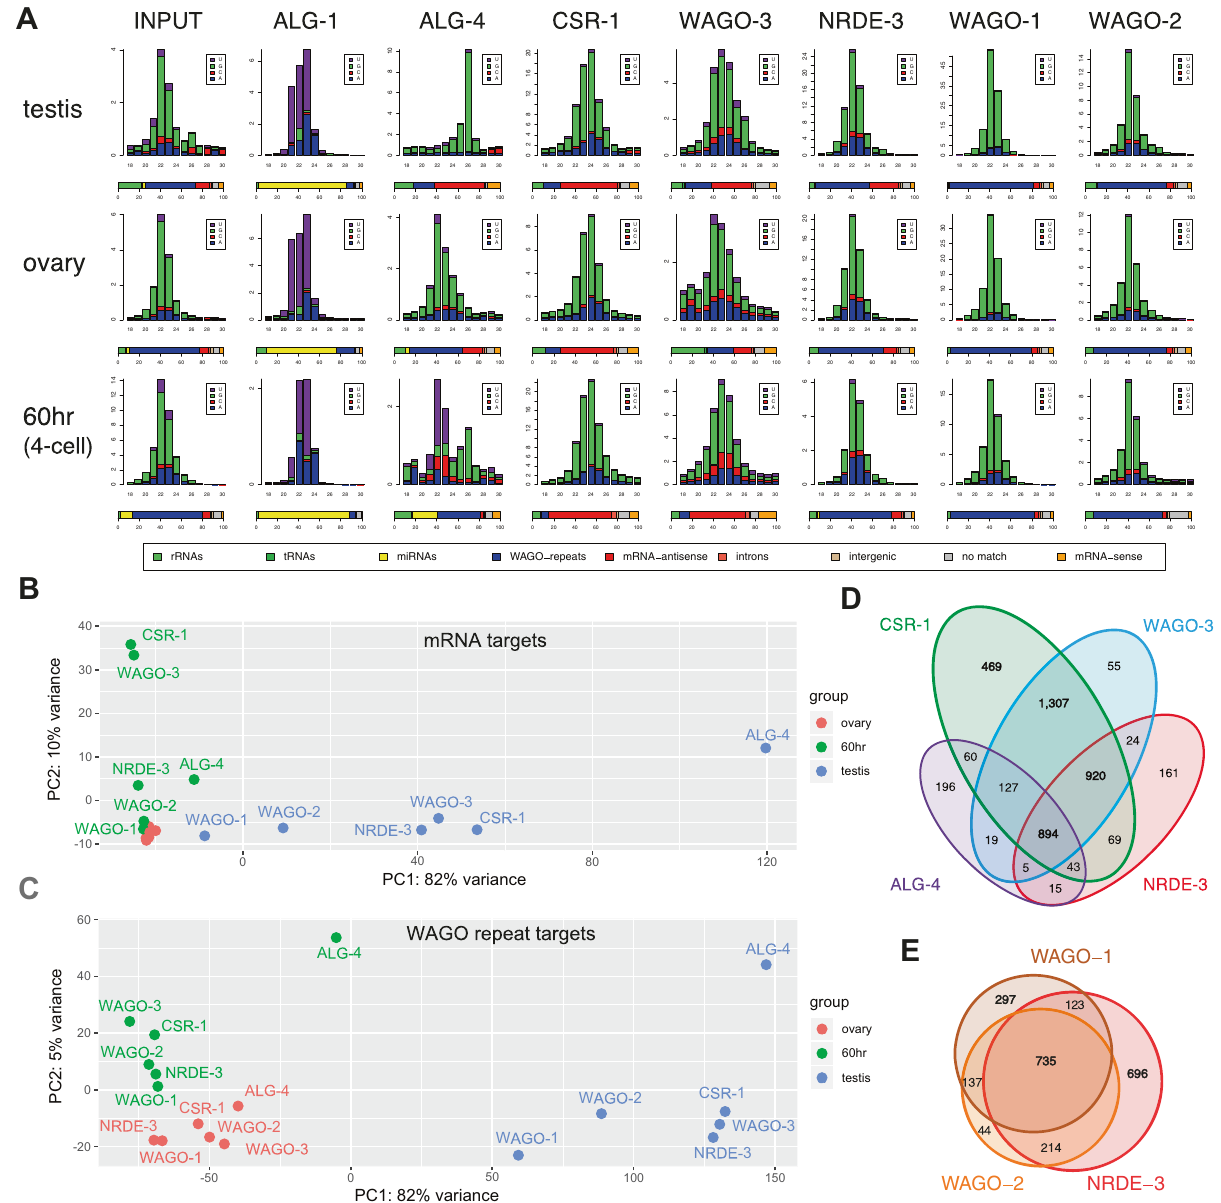
Fig. 2 Ascaris Argonautes bind speci fi c sets of small RNAs. A Size distribution, frequency, and targets of small RNAs associated with speci fi c Argonautes. Small RNAs (18 – 30 nt) from input and Argonaute immunoprecipitation (IP) were plotted for the whole testis (male germline), whole ovary (female germline), and 4-cell embryo (60 h). In these and all subsequent small RNA size distribution fi gures, small RNAs starting with A, C, G, and U of different sizes ( x -axis) were plotted against their read frequencies ( y -axis; raw reads in millions). Data are derived from two or more biological replicates combined. The small RNAs were categorized by their type (miRNA) or complementarity to different targets as shown in percentage bars below each size distribution plot. The target categories are sequences matching: (1) rRNAs or (2) tRNAs; (3) miRNAs; (4) repetitive sequences and mobile elements that are targets of AsWAGO-1, AsWAGO-2, and AsNRDE-3 (WAGO-repeats); (5) siRNAs antisense to mRNAs; siRNAs matching (6) introns or (7) intergenic regions; (8) small RNAs that have no full-length match to the genome (no match); (9) and sense small RNAs that correspond to mRNAs. B , C Principal component analysis (PCA) of small RNAs associated with Argonautes in different stages showing the overall relationship among these small RNA libraries. Panel B is PCA analysis of small RNAs that target mRNAs and C is small RNAs that target the WAGO-repeats. D, E Venn diagram showing the Argonaute small RNA overlapping targets in the testis for mRNAs ( D ) and WAGO-repeats ( E ). Source data are provided as a Source Data fi